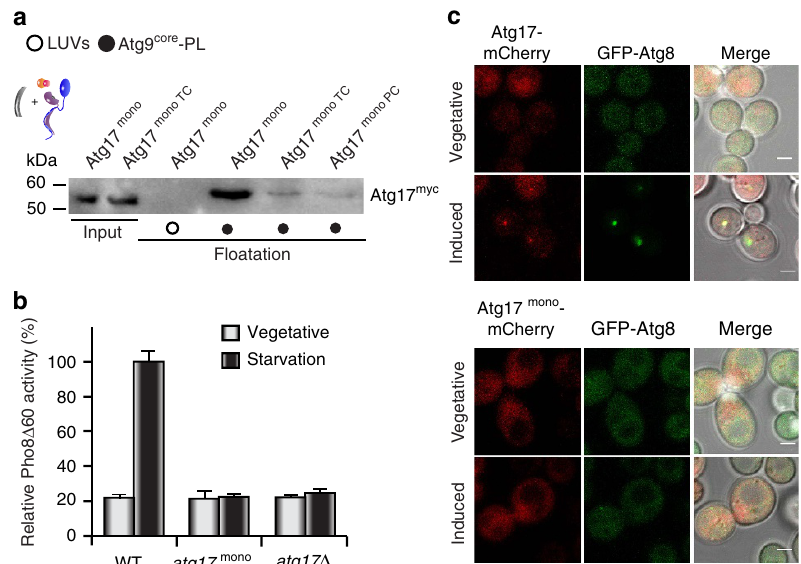
Figure 5 | The dimerization domain of Atg17 regulates Atg17-function. ( a ) a -myc immunoblots from co-floatation experiments of Atg9–PLs with recombinant myc-tagged, monomeric Atg17 (Atg17 mono ), Atg17 monoTC and Atg1 monoPC . Atg17 mono is strongly inhibited by Atg31–Atg29, but Atg17 monoTC is not activated by Atg1–Atg13. Similar experiments with large unilamellar vesicles (LUVs) lacking Atg9 core served as controls. Input corresponds to 10% of total protein used for co-floatation. ( b ) Pho8 D 60 assay of wildtype (WT), atg17 mono , and atg17 D cell lysates to assess autophagic activity under vegetative (grey bars) and starvation (black bars) conditions. Mean values ± s.d. of N ¼ 3 independent experiments are shown. ( c ) Co-localization of GFP-Atg8 with mCherry-tagged Atg17 or Atg17 mono under vegetative or autophagy-induced conditions. Atg17 mono is not forming puncta under autophagy-induced conditions. Consequently, autophagosomes are not being formed as apparent from the lack of Atg8-puncta. Scale bar, 2 m m. NATURE COMMUNICATIONS|7:10338|DOI: